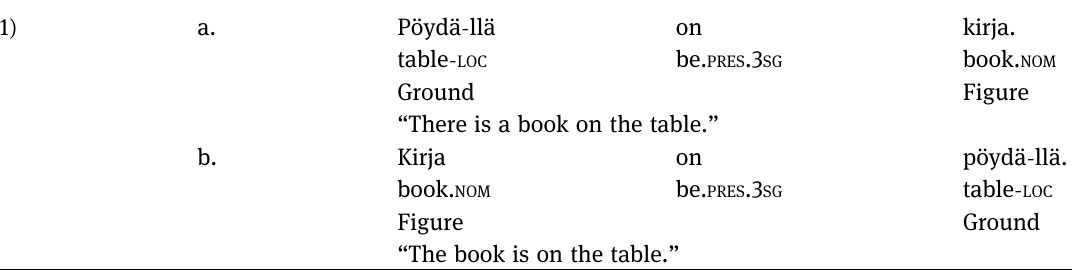
Pöydä - llä on table - LOC be. PRES .3 SG book. NOM Ground Figure “ There is a book on the table. ” b. on pöydä - llä. book. NOM be. PRES .3 SG table - LOC Figure Ground “ The book is on the table. ”